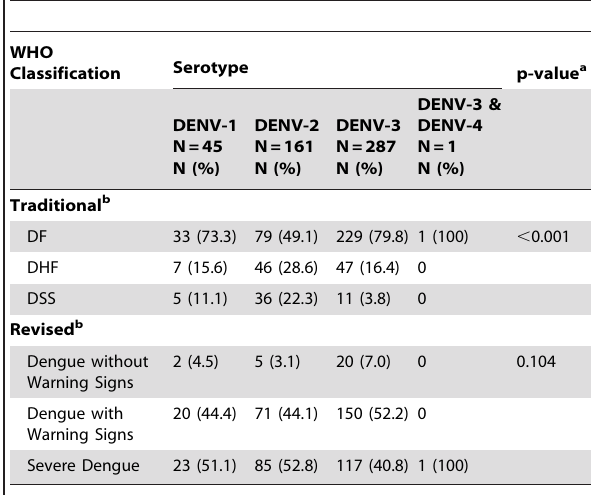
Table 6. Concordance a between clinical diagnosis and diagnosis by computer algorithm according to the traditional WHO classification.